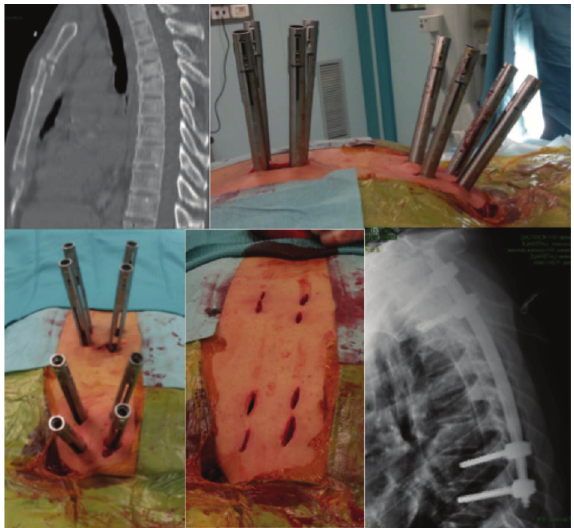
Figure 2: A 41-year-old man with traumatic fractures of T4-T5- T6 and fracture of the sternum. A completely percutaneous long fixation was carried out from T2-T3 till T8-T9. The patient was discharged from the hospital on the third postoperative day.